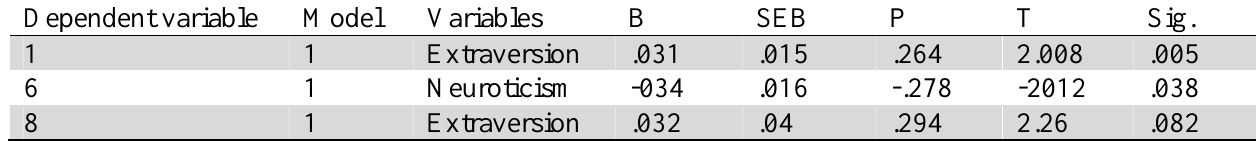
Stepwise multiple regressions of mate preferences based on personality characters Dependent